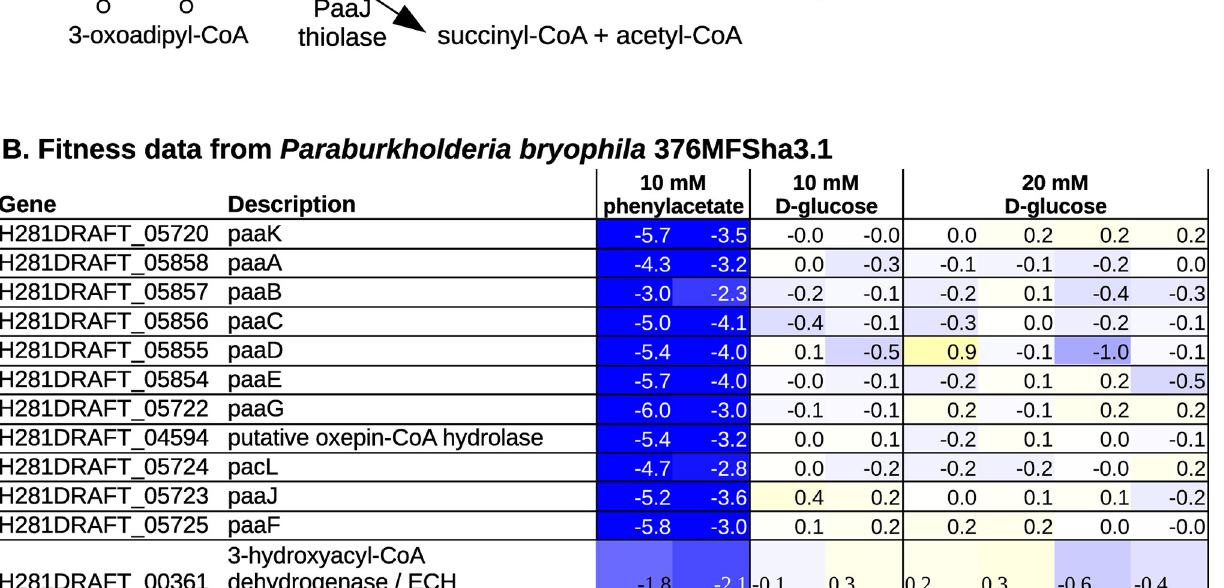
PLOS Genetics | https://doi.org/10.1371/journal.pgen.1010156 April 13, 2022 15 /